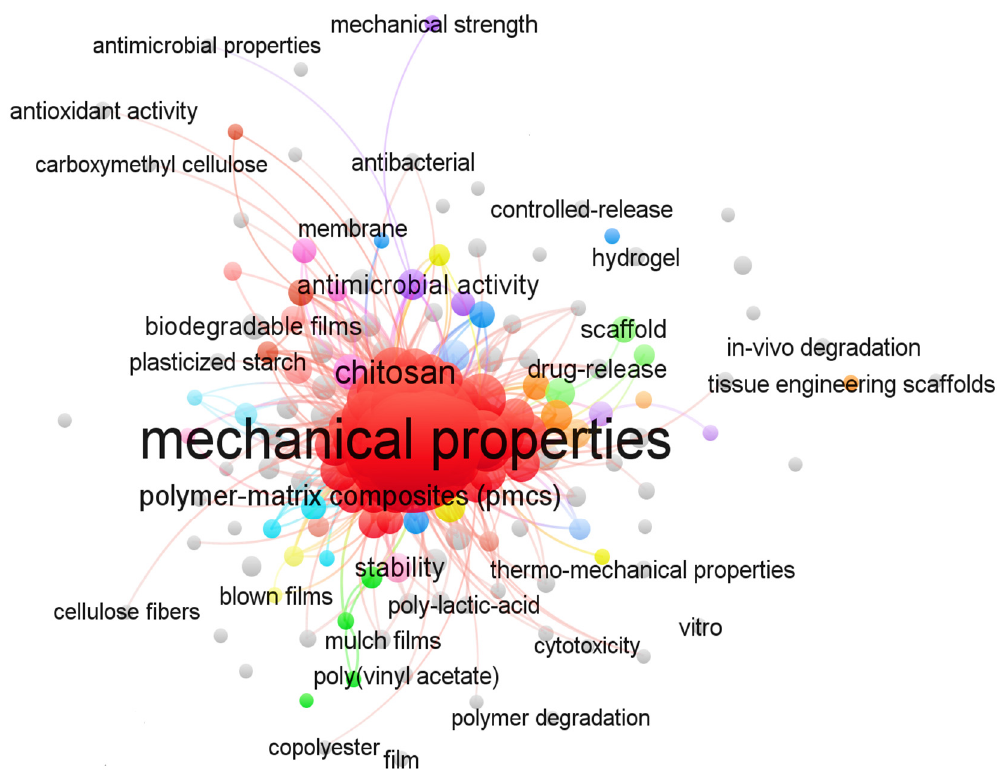
Figure 6. Systematic mapping summary of scientific advances in physicomechanics and thermostability in in vitro drug release studies of biopolymeric materials/biocomposites for biomedical applications.